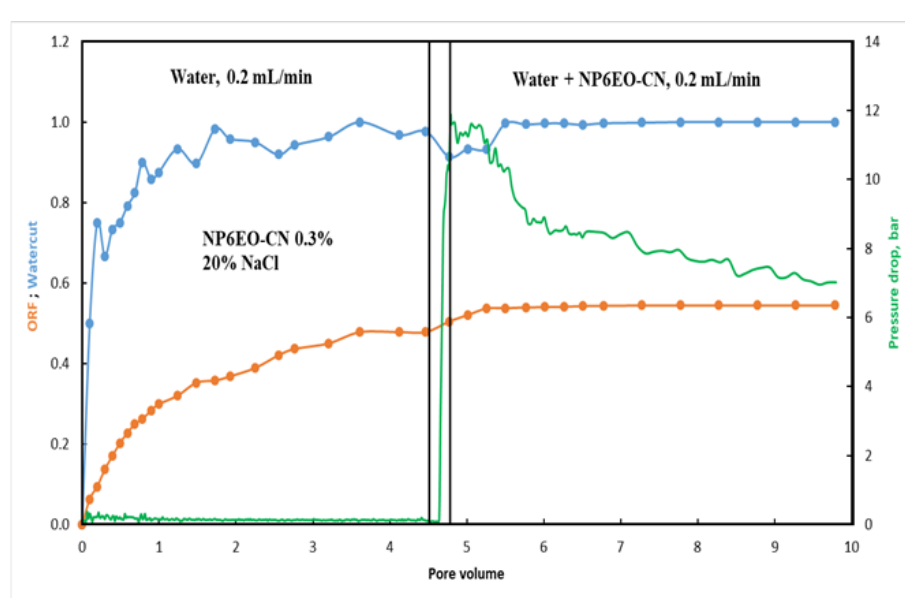
Figure 8. Oil displacement experiment of NP6EO–CN flooding.